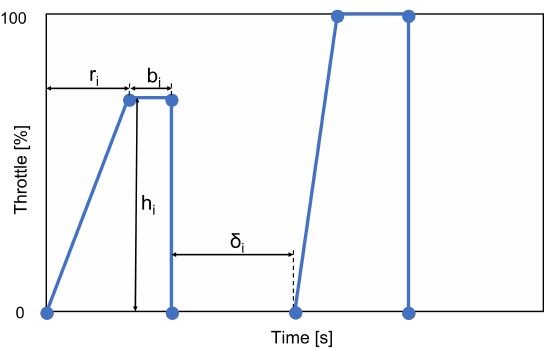
Figure 8. Throttle signal design variables.